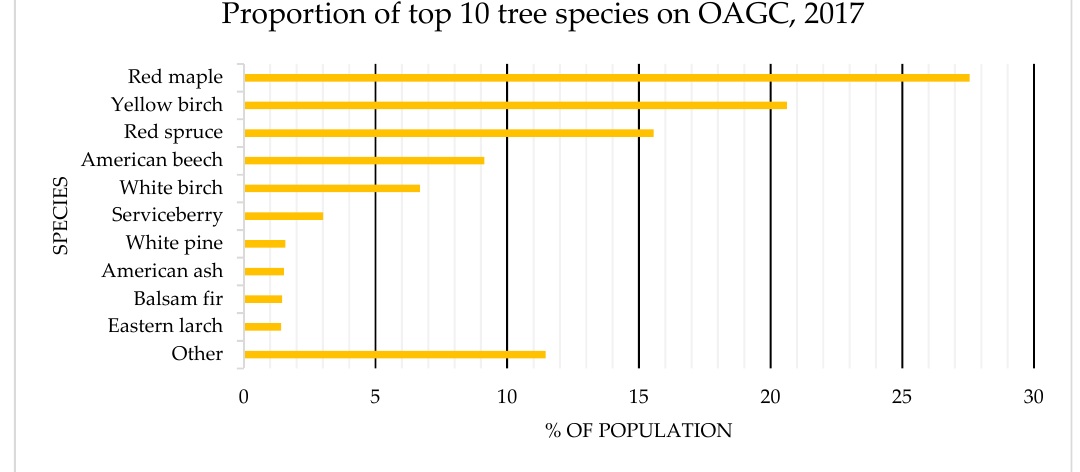
Figure 5. Ten most commonly occurring tree species found on OAGC in 2017. The high proportion of mid-successional species such as Red maple, Yellow birch, and Red spruce mixed with early successional species such as White birch, Serviceberry, and Balsam fir suggest a healthy, young forest. The representation of only one later successional species, American beech, indicate that without management intervention this forest may not have the potential to flourish into an old-growth population.